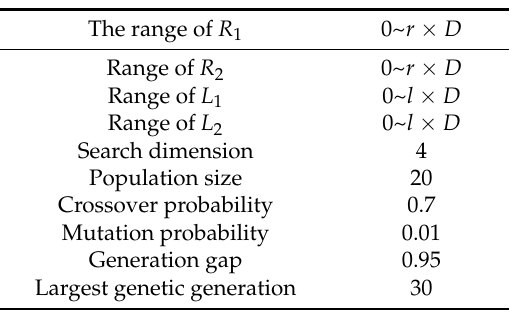
Table 3. The initial population values of the genetic algorithm.